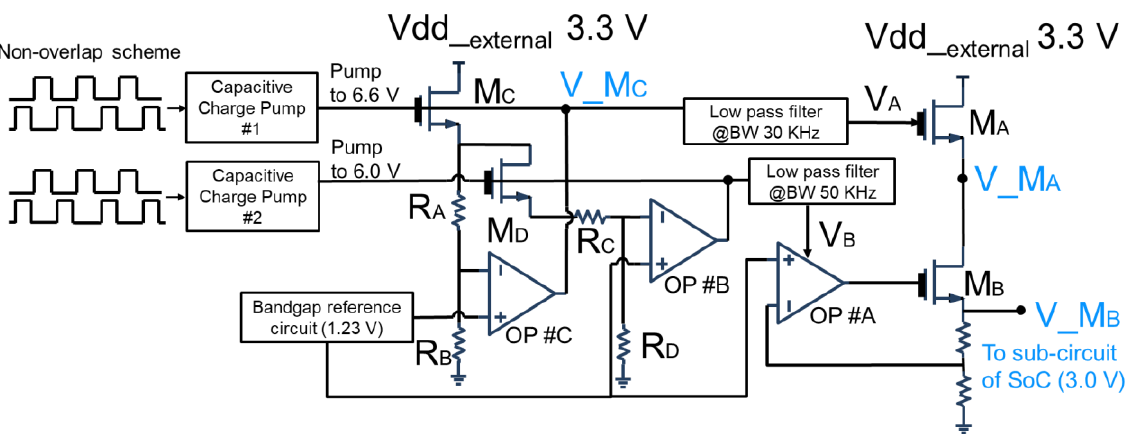
Figure 14. The proposed low-jitter dropout regulator.